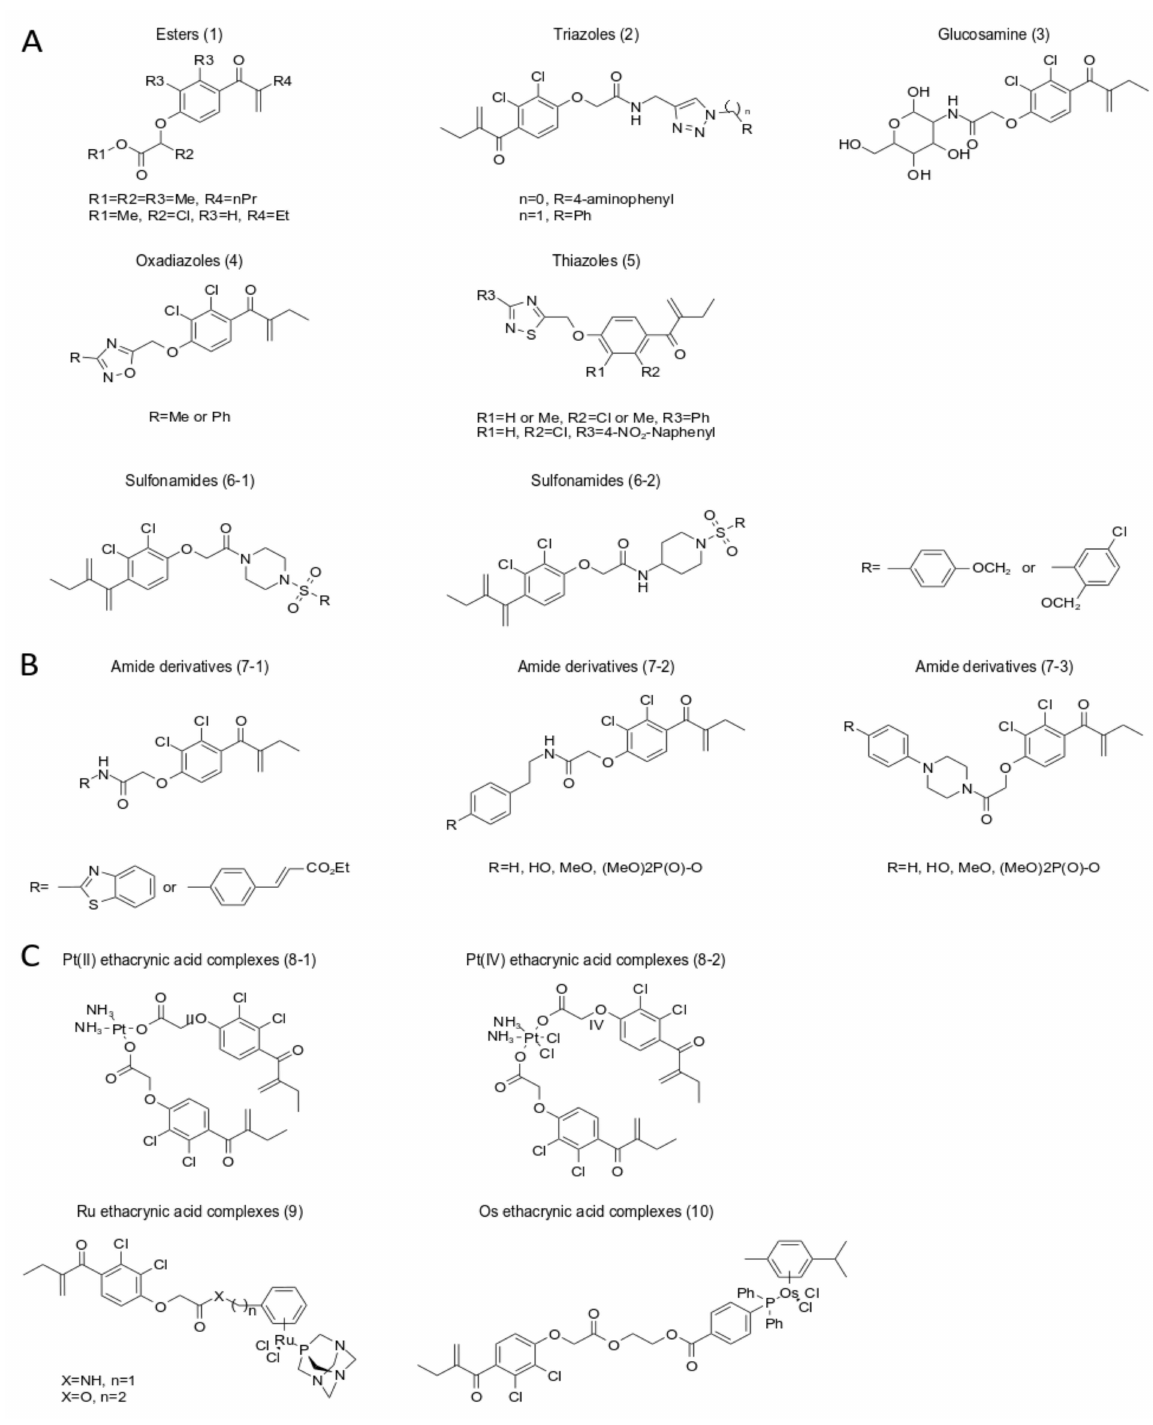
Figure 6. Chemical structures of several major ECA derivatives with anticancer potential. ( A ) Struc- ture of ECA derivatives containing ester, triazole, glucosamine, oxadiazole, thiazole, sulfonamide. ( B ) Structure of ECA derivatives containing amide. ( C ) Structure of ECA derivatives of transition metal complexes, such as platinum (Pt), ruthenium (Ru), and osmium (Os)